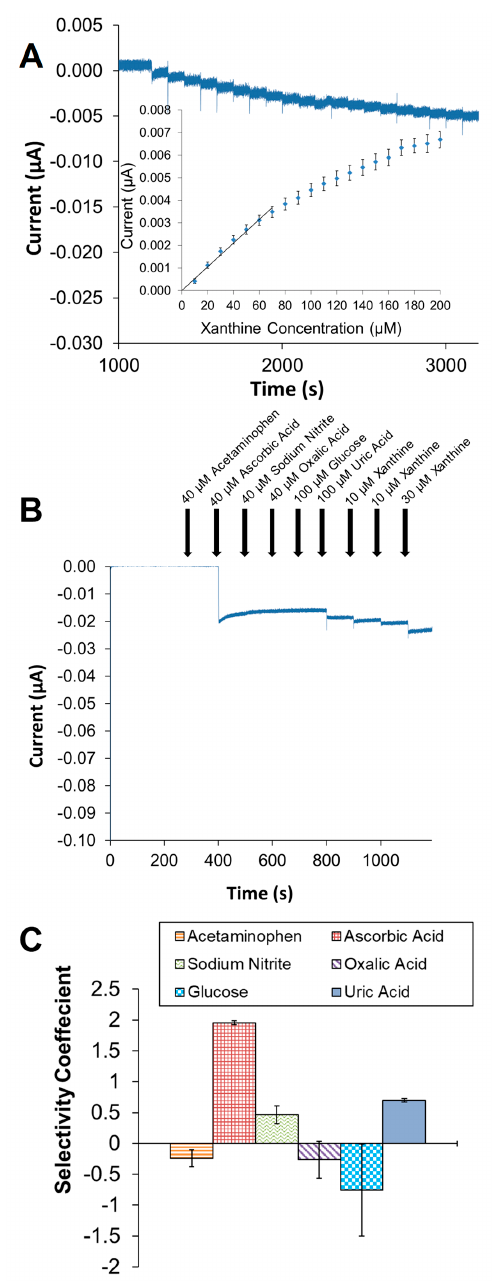
Figure 4. ( A ) Typical amperometric I-t response and calibration curve (inset) during successive 10 µ M injections of xanthine at a Pt-Ir wire electrode ( + 0.35V) modified with XOx-doped PTMS xerogels, polyurethane layer (100% HPU), and epoxy cap. ( B ) Typical amperometric I-t response and ( C ) calculated selectivity coe ffi cients during successive injections of common interferent species (40 µ M and / or 100 µ M) and xanthine (10 µ M and / or 30 µ M) at a Pt-Ir wire electrode ( + 0.35V) modified as in (A); Solution: 60.0 mM PBS, pH = 7.4, µ = 155 mM. Note: The error bars represent standard error (n ≥